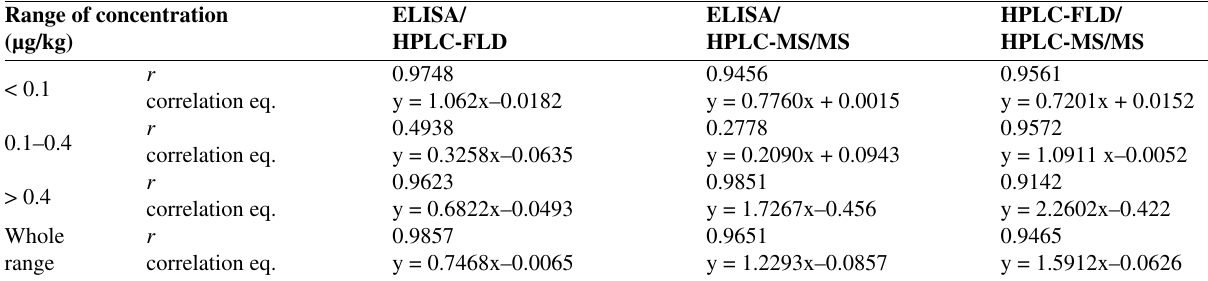
Table 4. Correlation coefficients and correlation equations between the applied methods Range of concentration